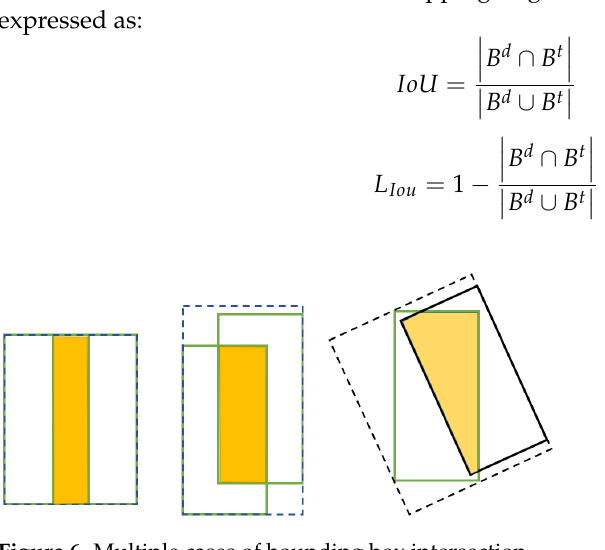
Figure 6. Multiple cases of bounding box intersection.